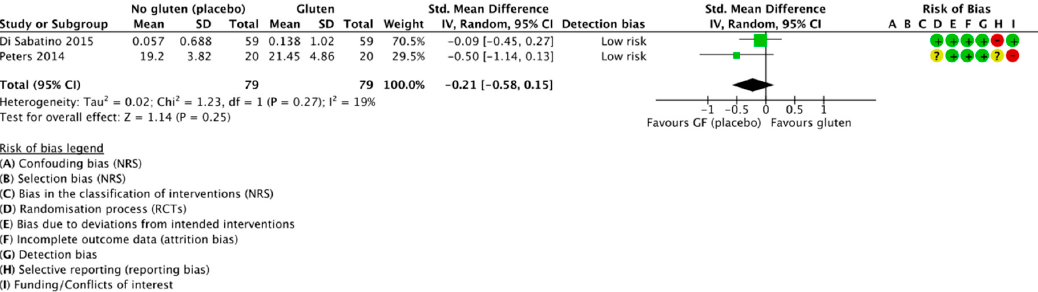
Figure 5. Forest plot demonstrating the difference in participant depression scores between gluten and placebo challenges in subjects with self-reported NCGS.